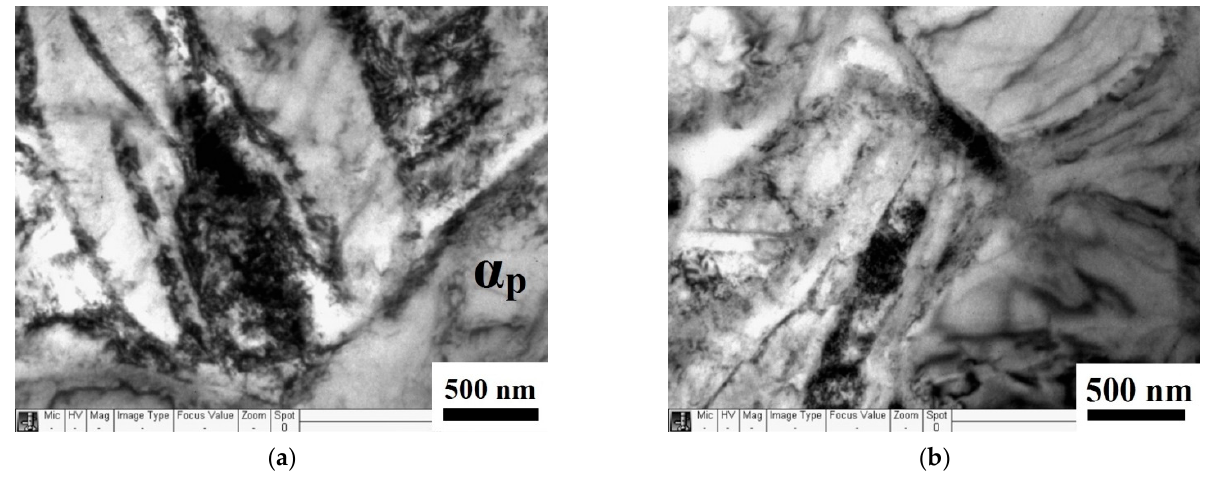
Figure 7. Microstructure of a near-surface layer of a CG Ti-6Al-4V sample after PEP + II: general view of structure disordering ( a ); blocks with high dislocation density ( b ). TEM.